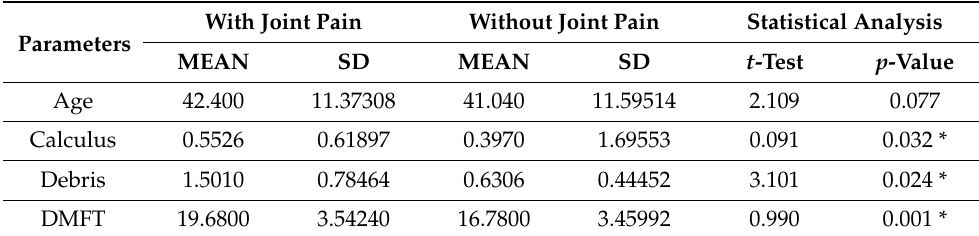
Table 3. Mean values of oral hygiene parameters in both the